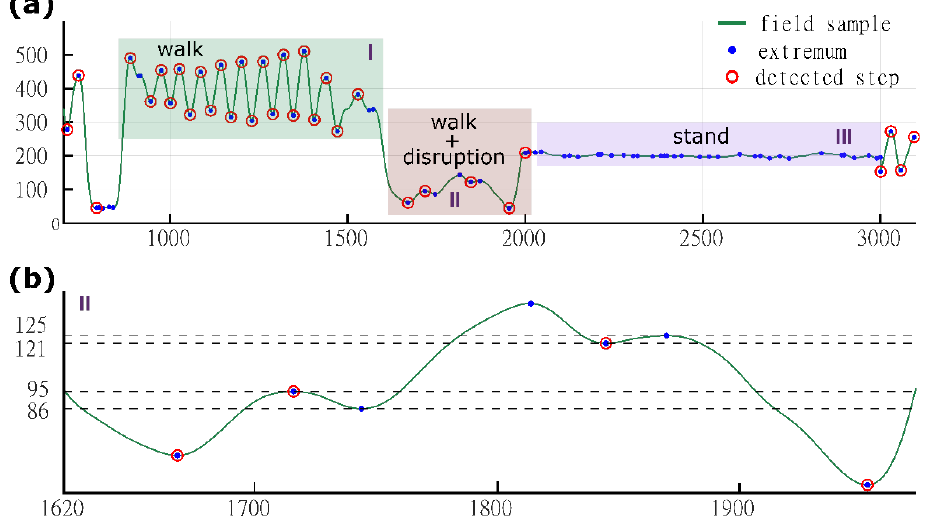
Figure 5. Extrema filtration and step detection in the low frequency component of magnetic field signal variation recorded during complex walk activity ( a ). Threshold discriminator for fake extrema rejection ( b ).